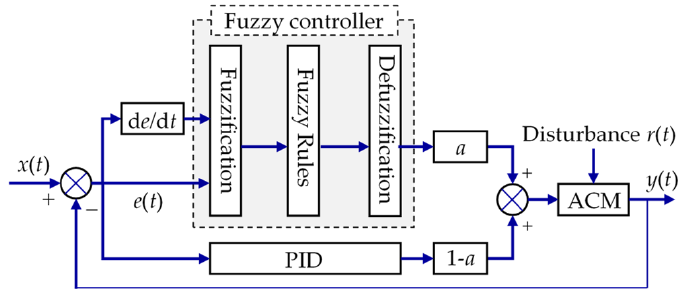
Figure 10. Hybrid fuzzy PID control block diagram.